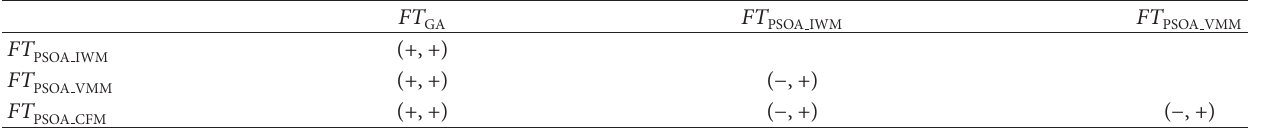
Table 10: Multiple comparison on execution time.